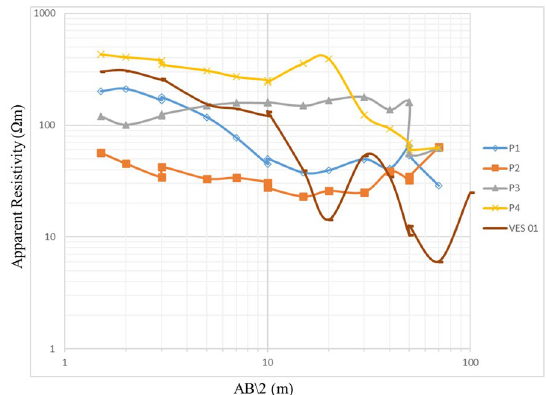
Fig. 11 Apparent resistivity curves of the four VES points (P1, P2, P3, and P4) versus the apparent resistivity curve of survey location VES 01. (Note that VES 01 curve has the same disturbed nature as the survey points P1, P2, P3, and P4)